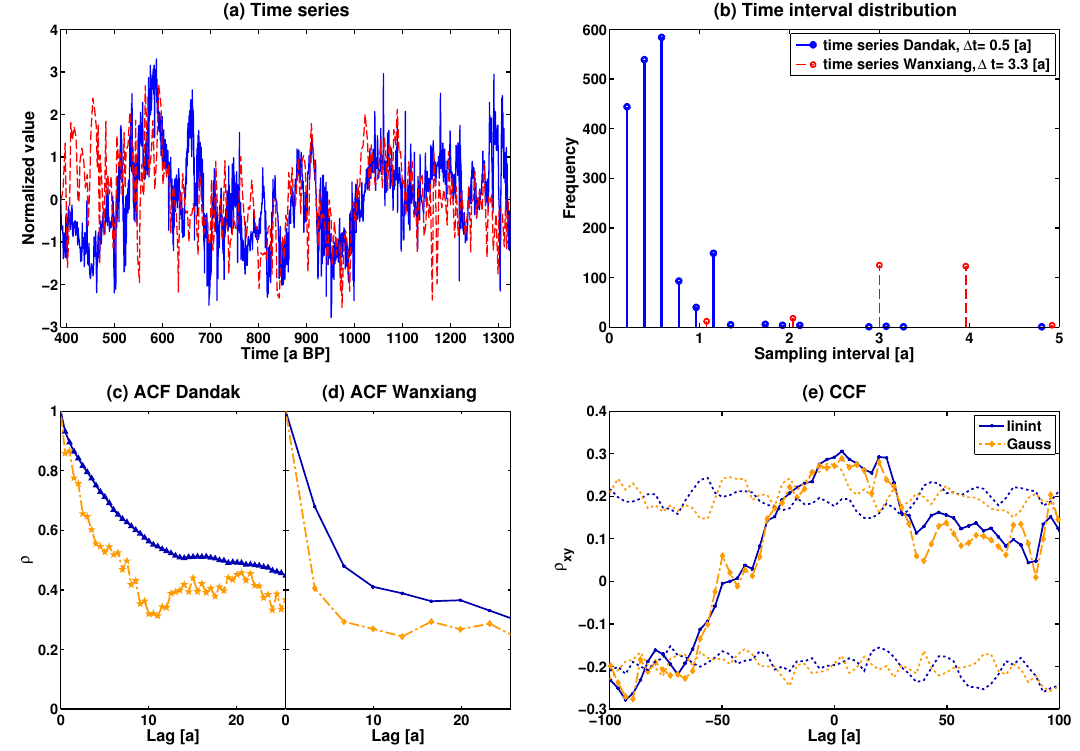
Fig. 12. Exemplary cross correlation analysis of δ 18 O records from Dandak and Wanxiang caves: Standardized time series (a) , the sampling interval distributions (b) , the estimated ACFs (c, d) and the corresponding CCF with the dashed lines representing the estimated 95% critical values of a two-sided test for the null hypothesis of time series being sampled from a red noise process (e) . Legends for each row are given in the right panels.